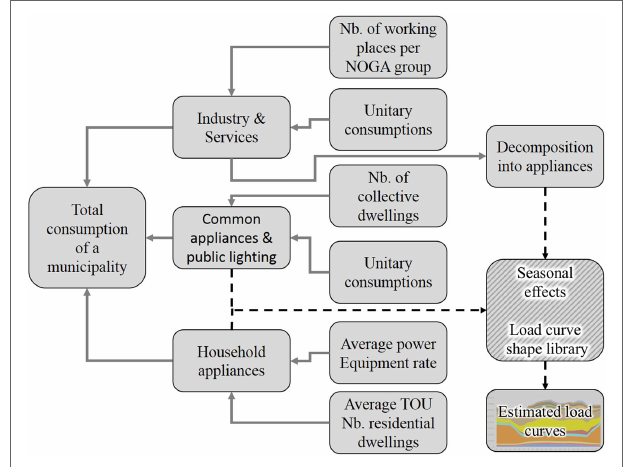
FIGURE 5 | Overview of the geo-dependent electricity demand